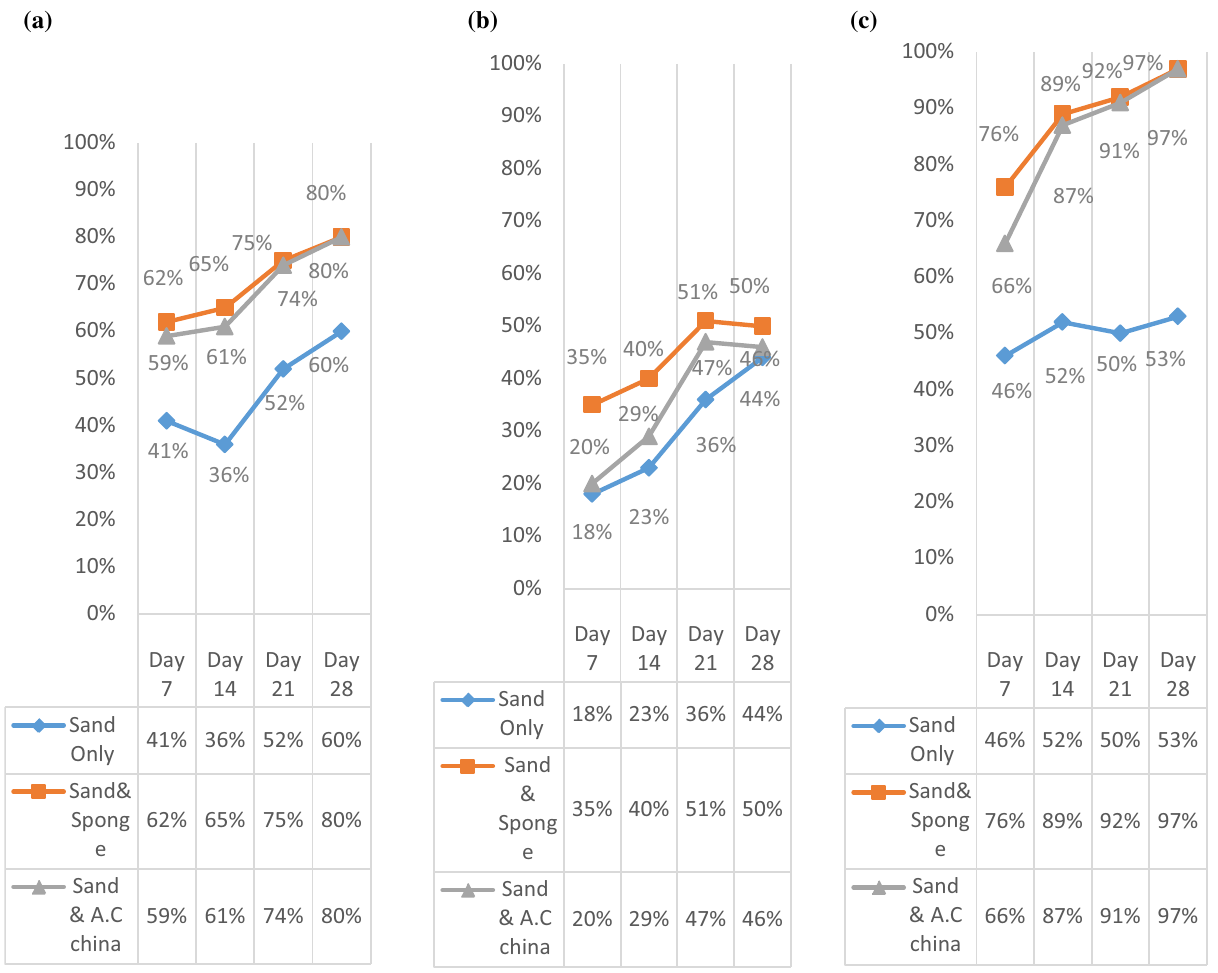
Fig. 9 Results obtained from run (1), a %R.E. of COD